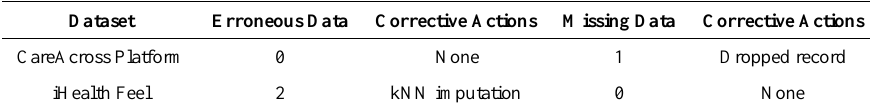
Figure 8. Output of CareAcross data from the Data Cleaning component Table 5. Overall cleaning